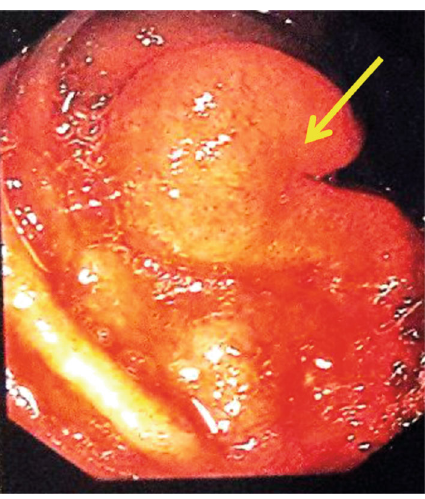
Figure 1: Yellow arrow shows the endoscopic appearance of bleeding varix at proximal jejunum.